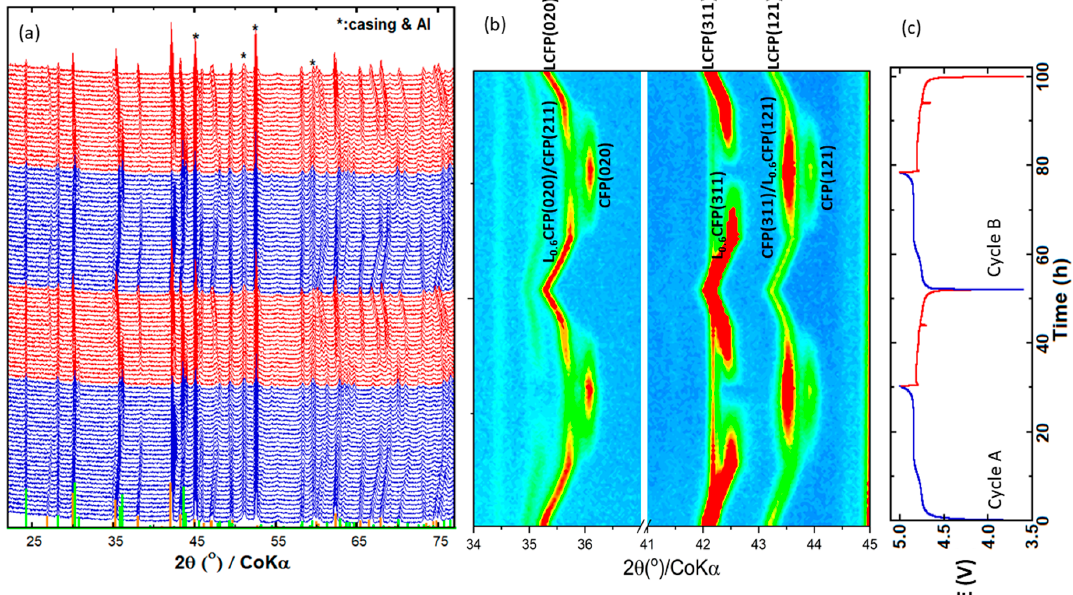
Figure 4. Evolution of the XRD patterns of a Li / LCFP half-cell cycled at a rate of C / 30. ( a ) Full 2 θ range; ( b ) contour plot of the (020), (311), and (121) lines; ( c ) corresponding voltage–time profile (the displayed cycles correspond to the 2nd and 3rd cycles of the cell, while the 1st formation cycle is not plotted). Blue = charge; red = discharge. Peak bars at the bottom of ( a ): orange = LiCoPO 4 / PDF-04-007-4779; green = CoPO 4 /PDF-04-014-7341.